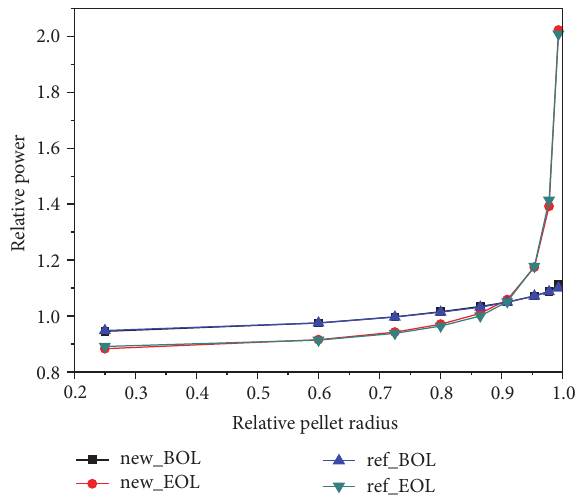
Figure 14: Relative radial power distribution.